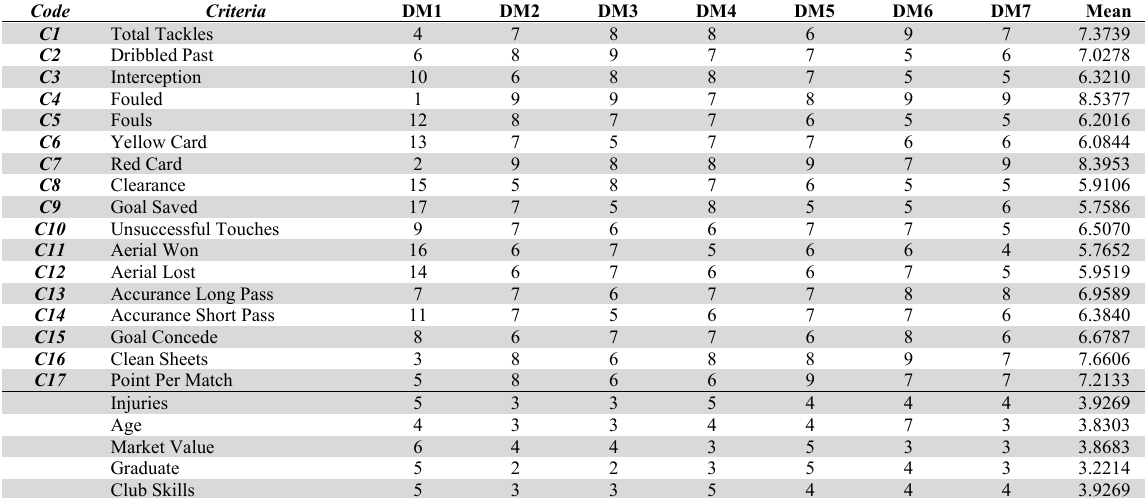
The selection criteria for goalkeeper selection and relative importance scores.